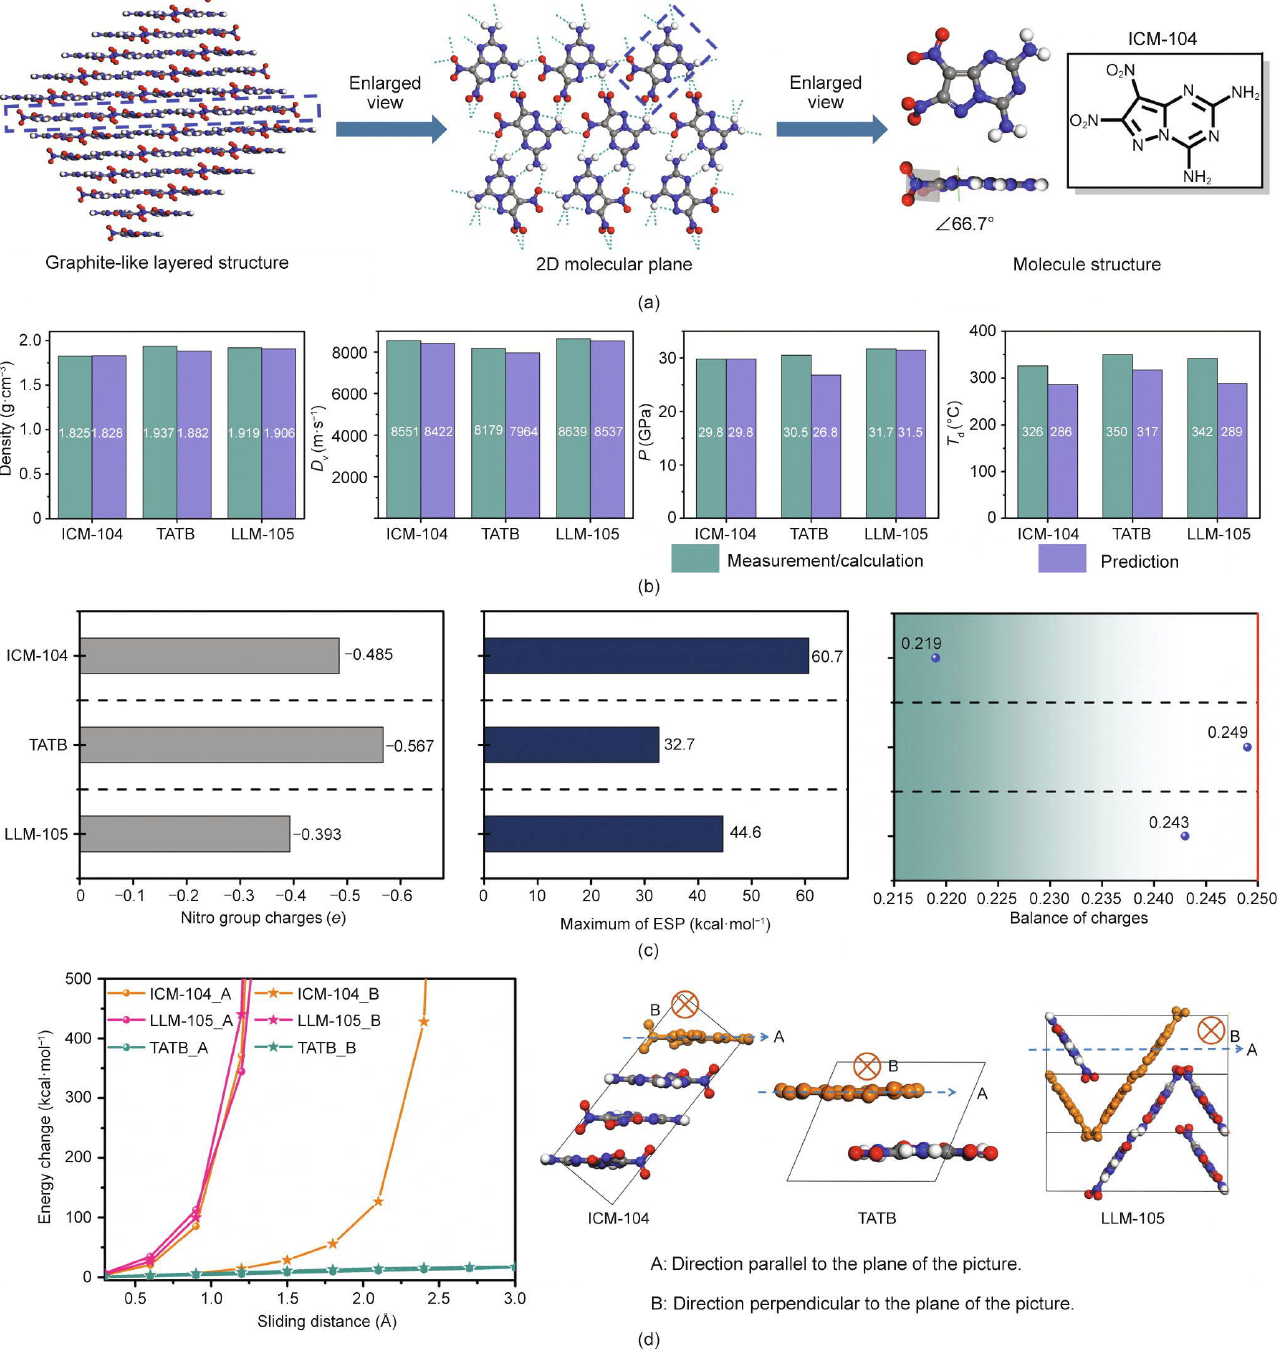
Figure 11. Crystal structure and properties of ICM-104. ( a ) Three-dimensional graphite-like layered crystal stacking, 2D supramolecular plane, and molecular geometry of ICM-104. ( b ) Comparison between the predicted and measured/calculated properties of ICM-104, TATB, and 2,6-diamino-3,5- dinitropyrazine-1-oxide (LLM-105). ( c ) Comparison of nitro group charges, maximum of electrostatic potential, and balance of charges of ICM-104, LLM-105, and TATB (1 kcal = 4.19 × 10 3 J). ( d ) Energy change for the layer sliding of ICM-104, LLM-105, and TATB [1]. Copyright 2022